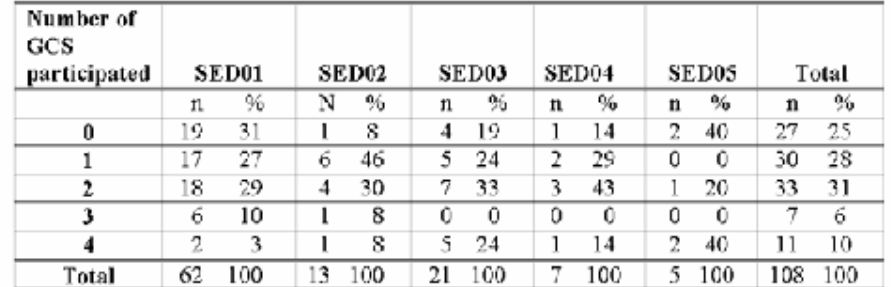
Table 7. Number of Group Counseling Sessions (GCS) attended by students who dropped out by